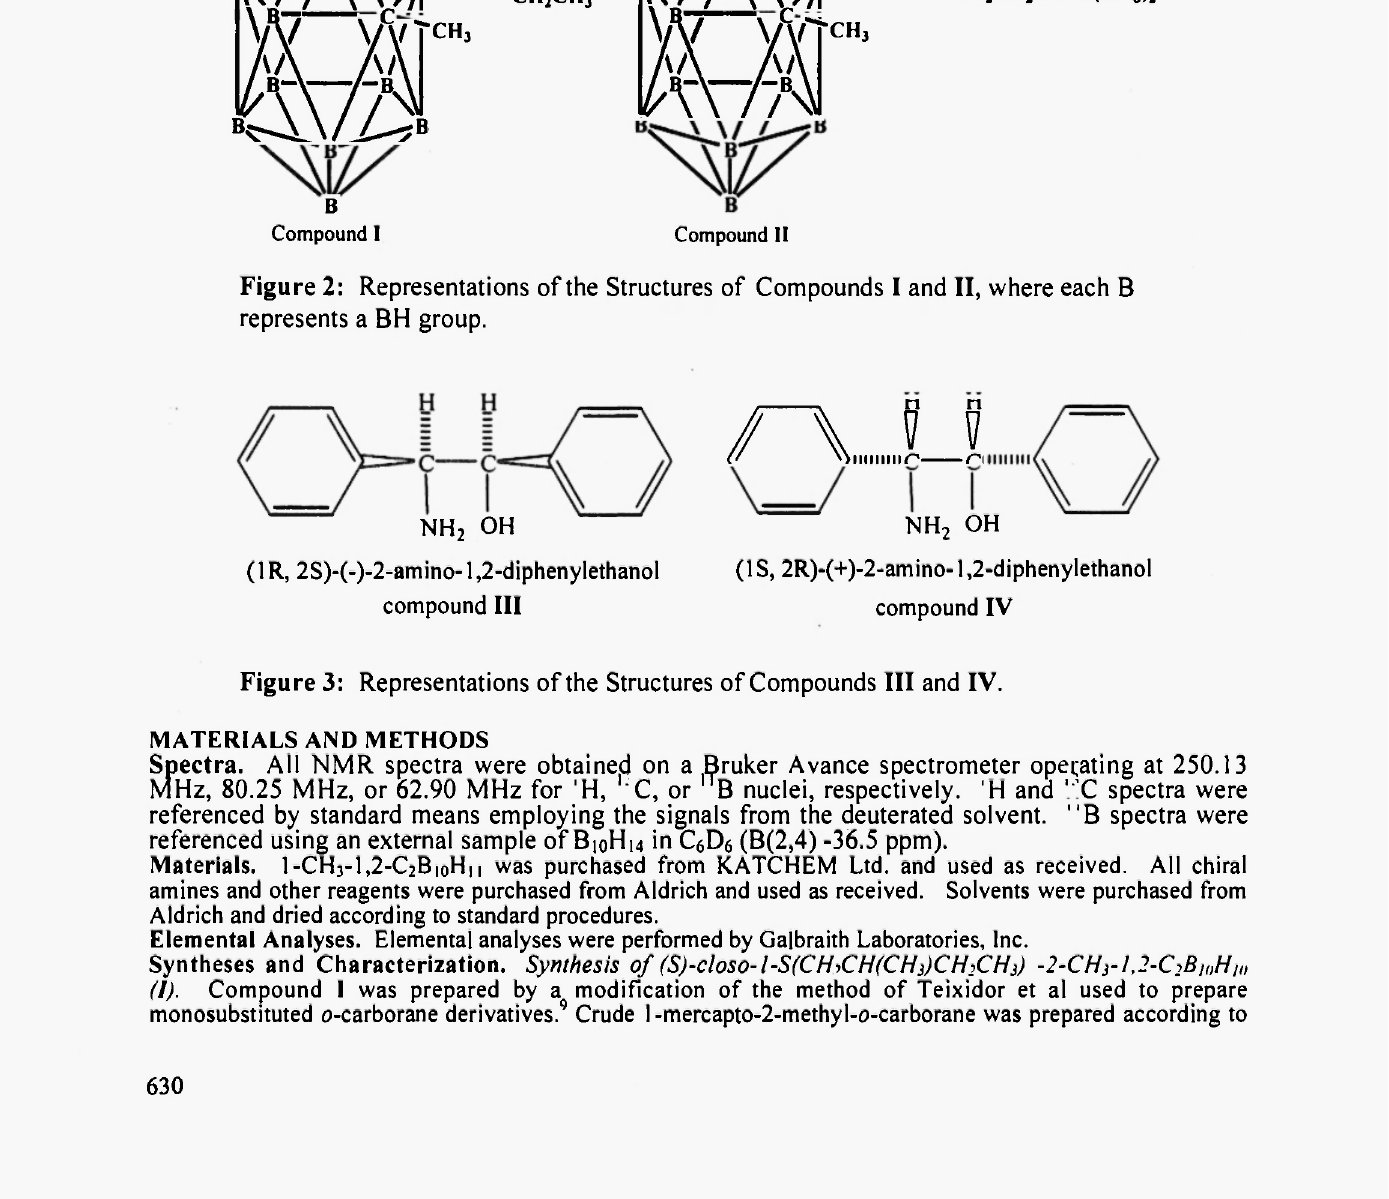
Figure 2: Representations of the Structures of Compounds I and II, where each Β represents a BH group.